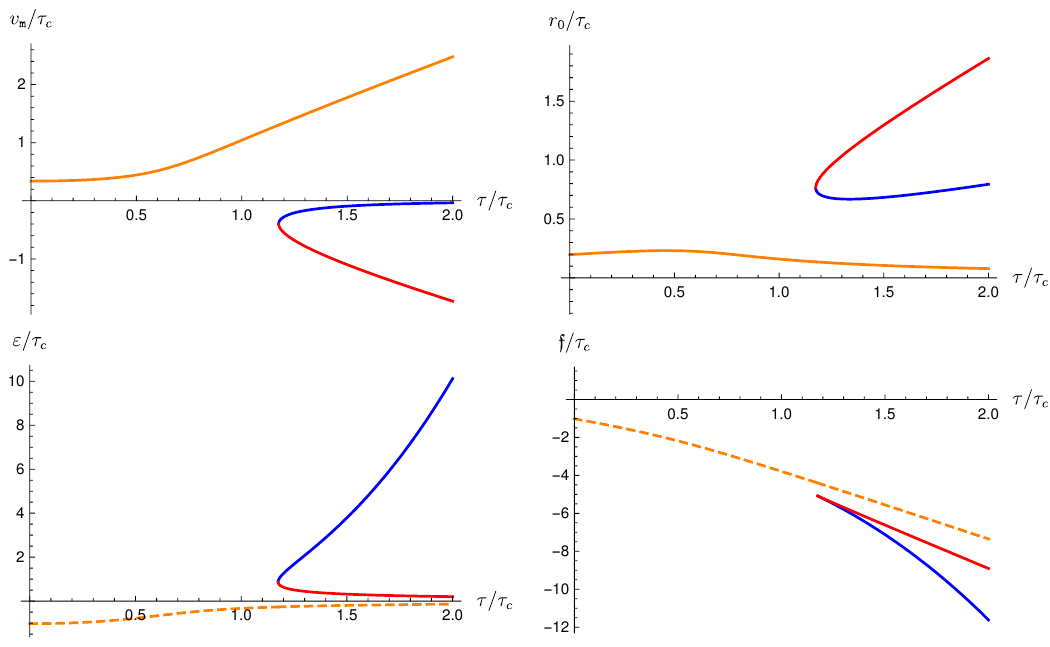
Figure 10 . Plot of the solutions of (6.24) for B = 0 : 786 B c , together with the corresponding energy " and Helmholtz free energy f densities.